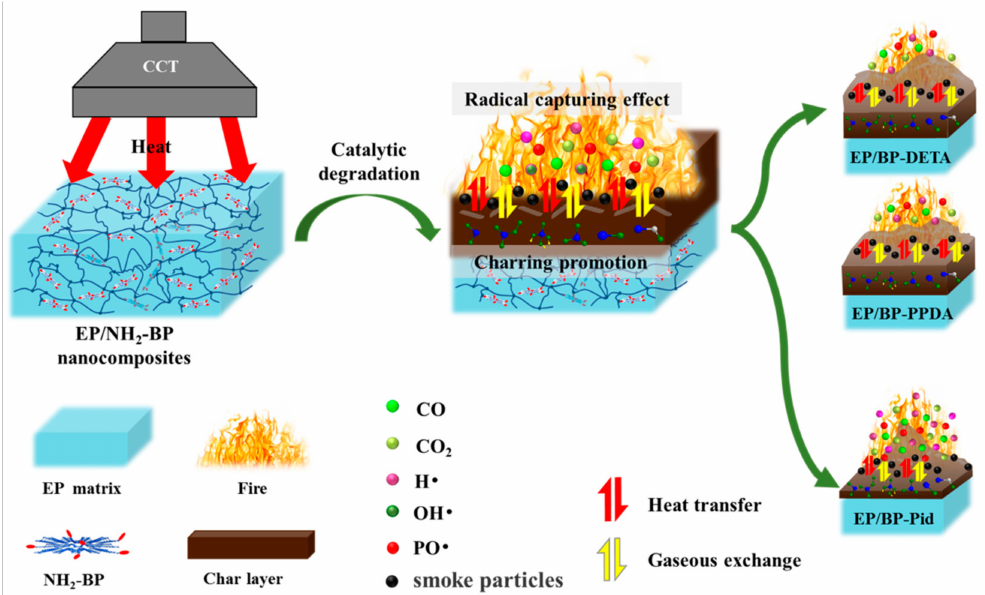
Figure 11. Flame-retardant mechanism of BP-NH 2 in EP.